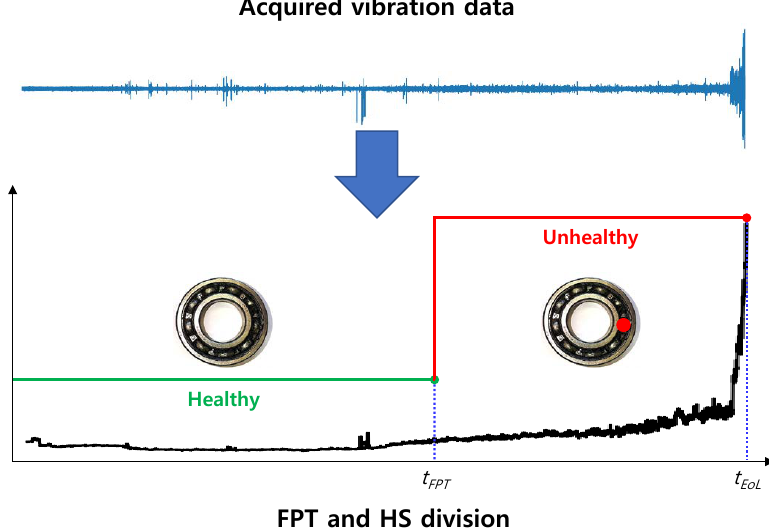
Figure 1. Degradation process with first predicting time (FPT) and health stage (HS)